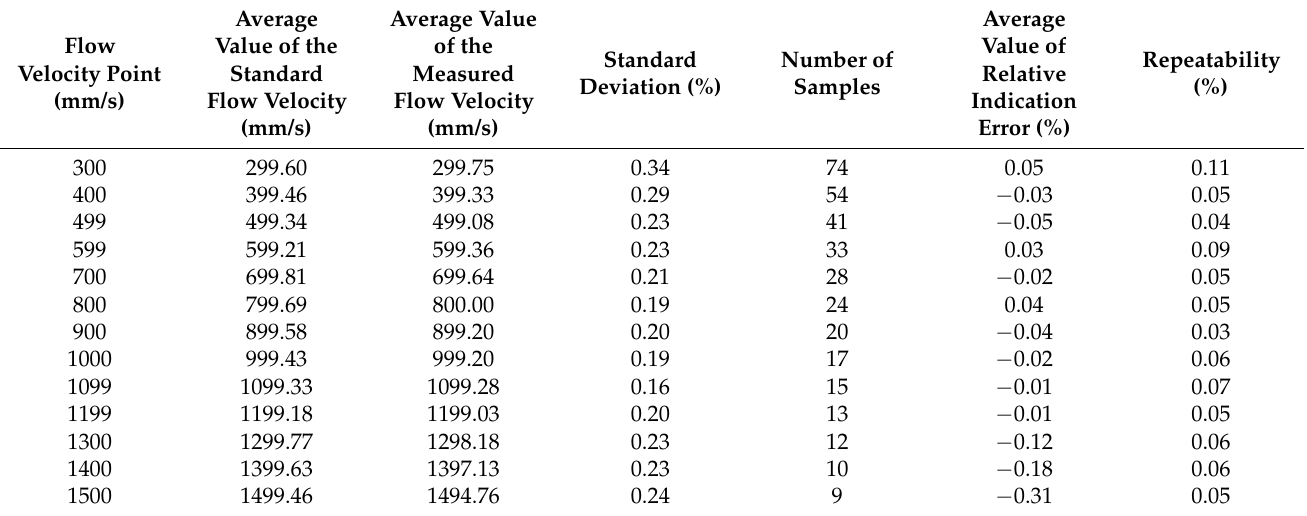
Table 2. Still water dragging method test data